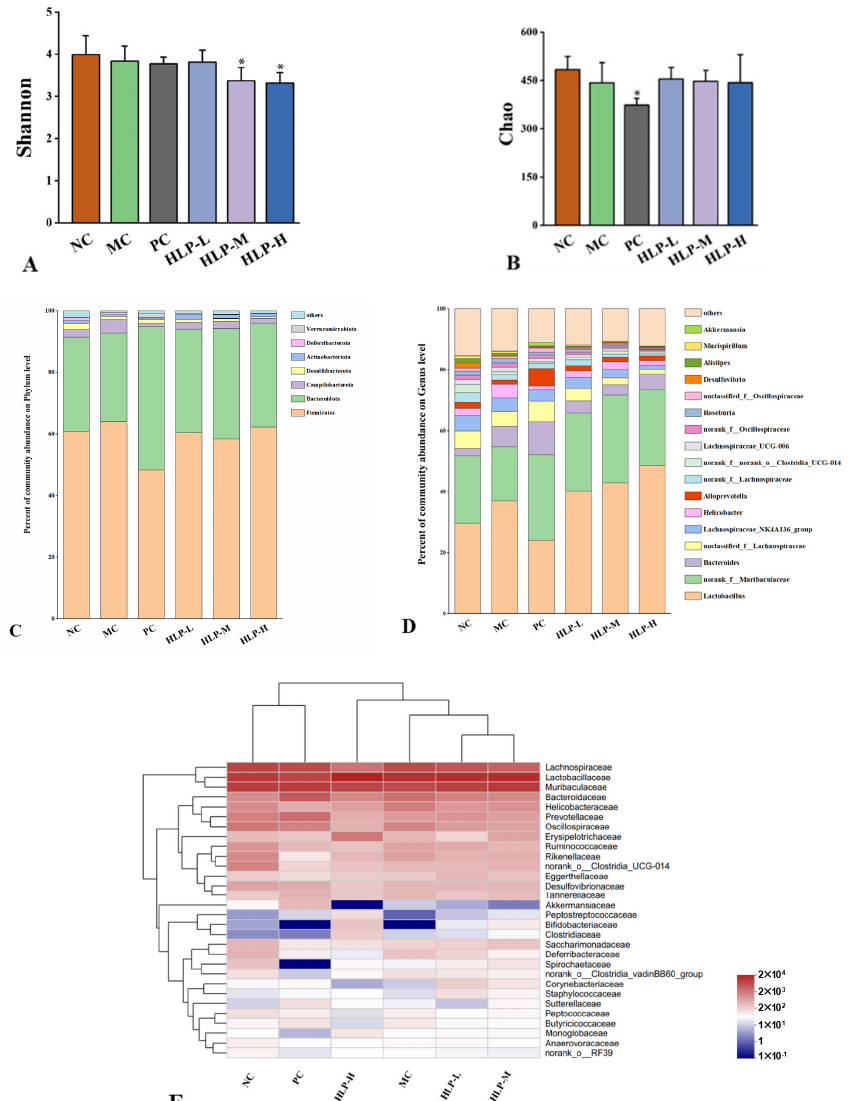
Figure 6. The effects of HLP on microbiota diversity and community structure in mice’s gut. ( A ) Shan- non and ( B ) Chao estimations of gut microbiota diversity. * p < 0.05 vs. MC group. NC: normal control group, MC: model control group, PC: positive control group, HLP-L: low-dosage HLP group, HLP-M: middle-dosage HLP group, and HLP-H: high-dosage HLP group. Changes of gut microbiota at the ( C ) phylumand ( D ) genus level. ( E ) Heat map comparison between experimental groups at the family